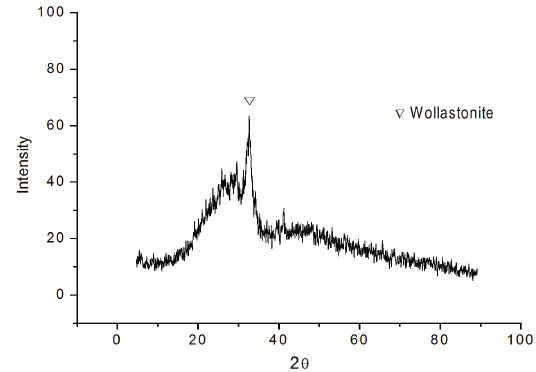
Figure 2. BG58S XRD spectrum.